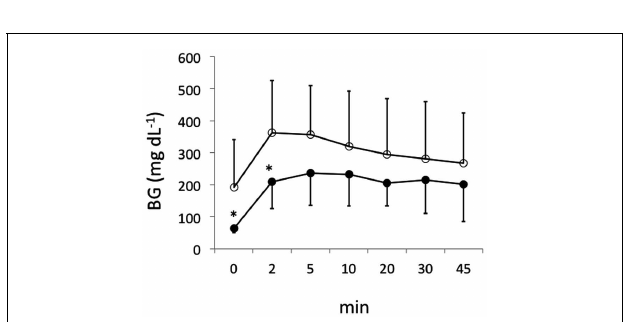
FIGURE 6 | Fasting blood glucose (BG) levels following intravenous tolerance tests of STZ induced diabetic Lewis rats. Tests were performed on day 56 following transplantation with islets from donor pancreata infused with HBSS/BSA solution containing 100 µ M mesobiliverdin IX α ( n = 7) (filled circles) or without mesobiliverdin IX α ( n = 9) (open circles). BG levels at 0 and 2min correlated with first-phase insulin function. * p values <